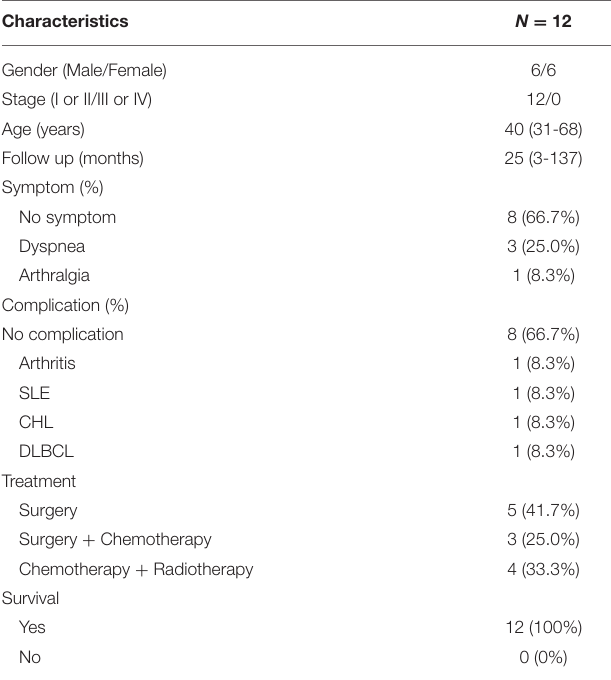
TABLE 1 | Clinic and biologic characteristics of the 15 cases with thymic MALT lymphoma.